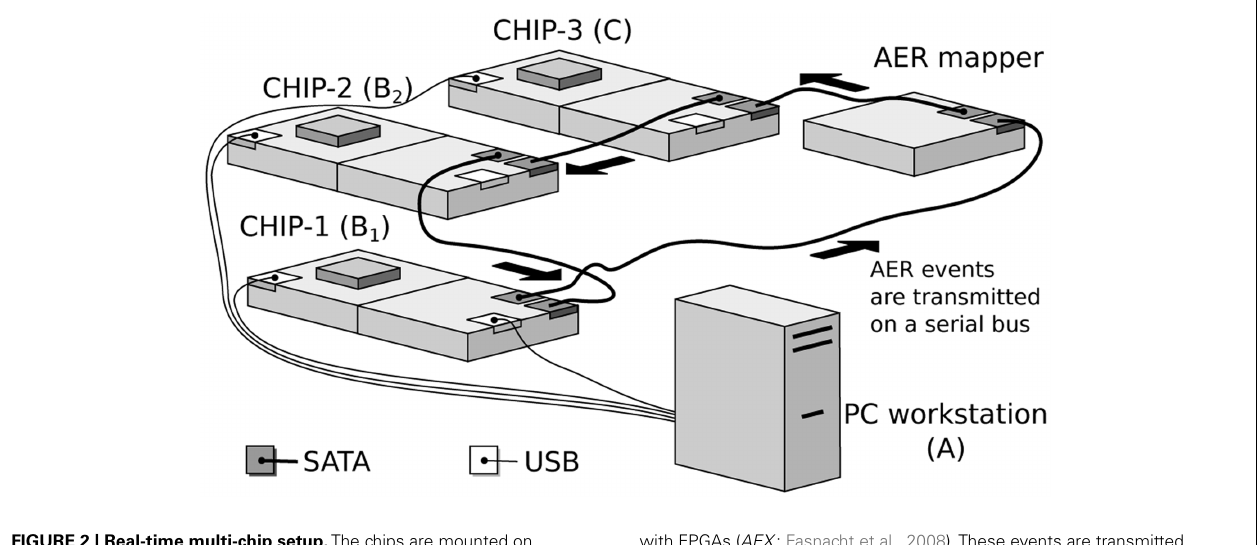
FIGURE 2 | Real-time multi-chip setup. The chips are mounted on custom PCBs ( AMDA ) which supply bias voltages to the chips.These biases can be configured via a USB interface connected to the PC workstation.The AER events are handled by dedicated PCBs equipped